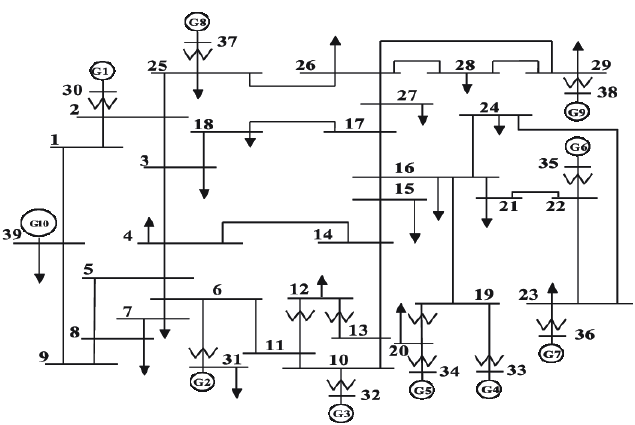
Figure 2. Network topology of IEEE 39-Bus system, with N = 39 buses (nodes) including 10 generators (buses 30–39) and 29 load buses